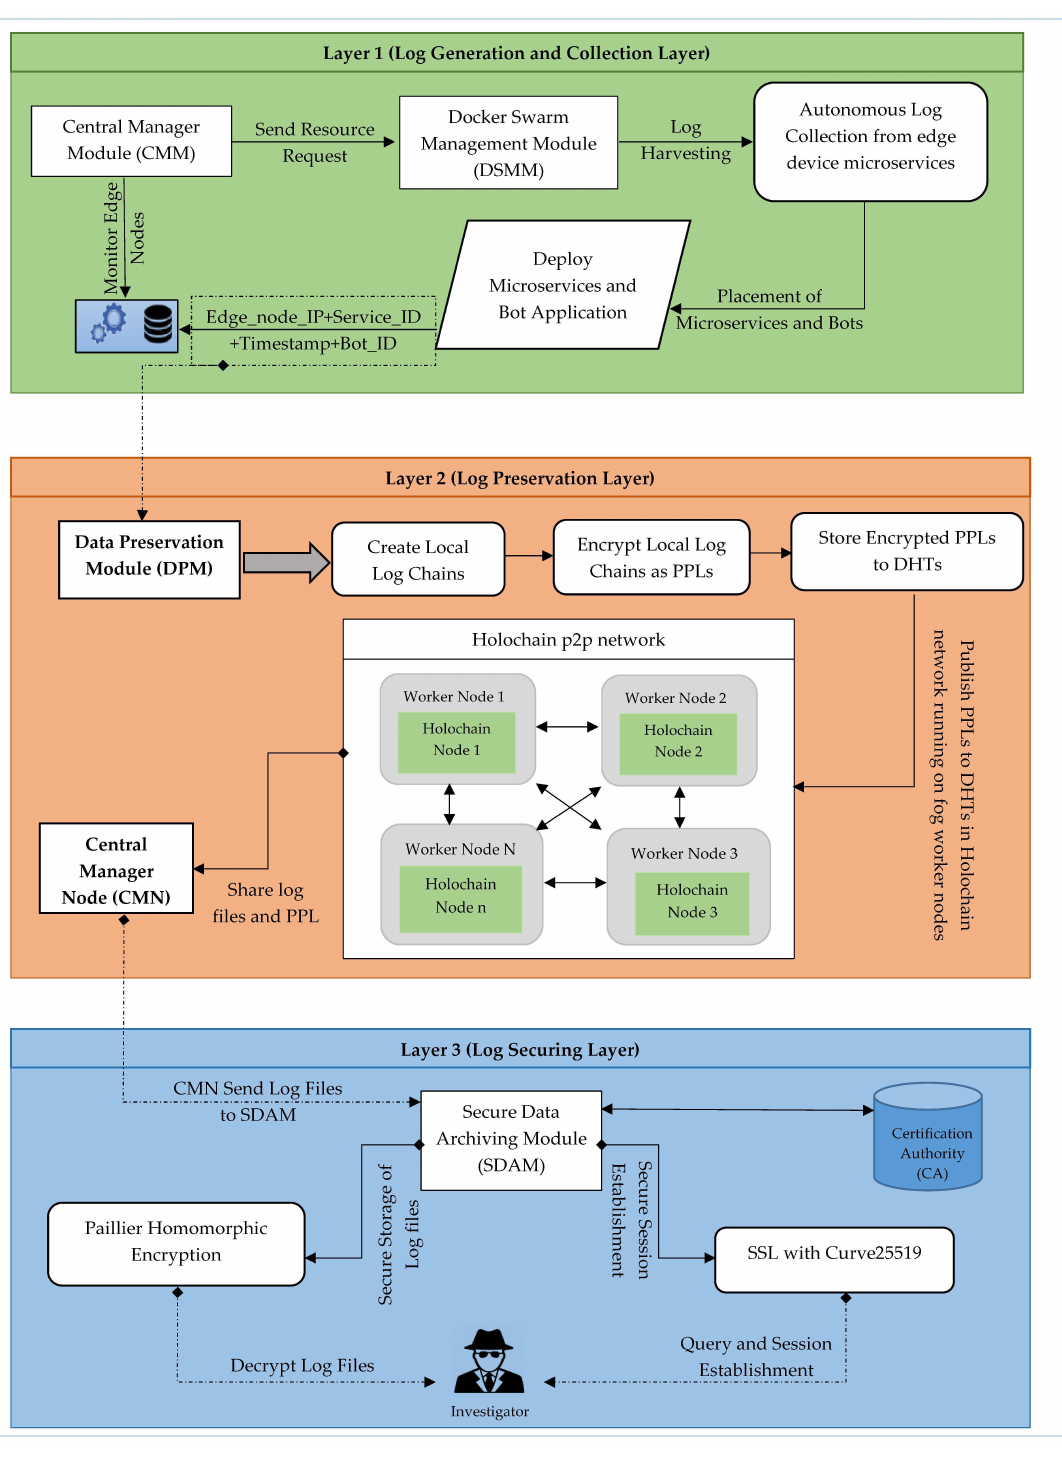
Figure 8. Details of procedures in PLAF